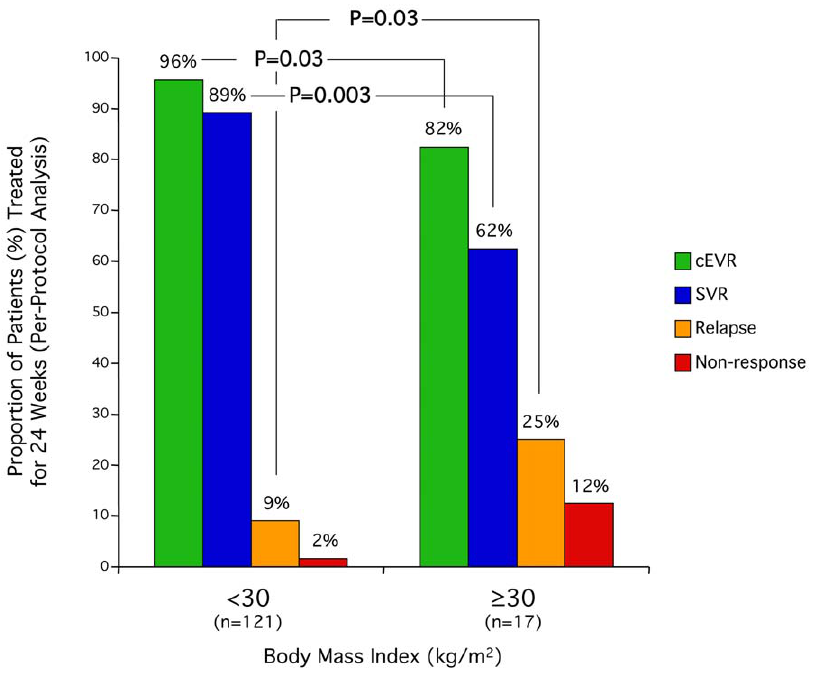
Figure 5. Impact of obesity on outcome. Histogram displaying the proportion achieving cEVR, SVR, relapse or non-response among patients treated for 24 weeks included in the per-protocol analysis grouped according to BMI. P-value obtained using Chi-squared test.